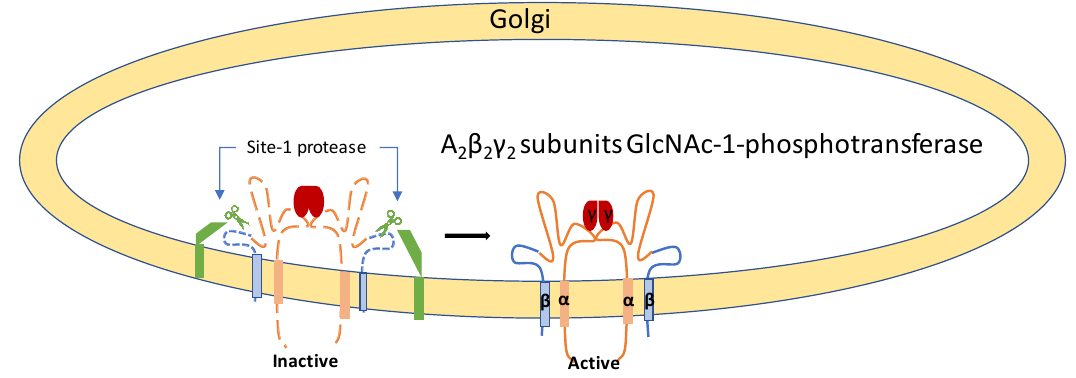
Figure 4. Structure of GlcNAc-1-phosphotransferase in Golgi. Adapted from Velho et al. (2019) [10]. GlcNAc-1-phosphotransferase comprises the α 2 β 2 γ 2 heterohexameric transmembrane protein. The site-1 protease cleaves inactive precursor protein and releases catalytically active α and β subunits.